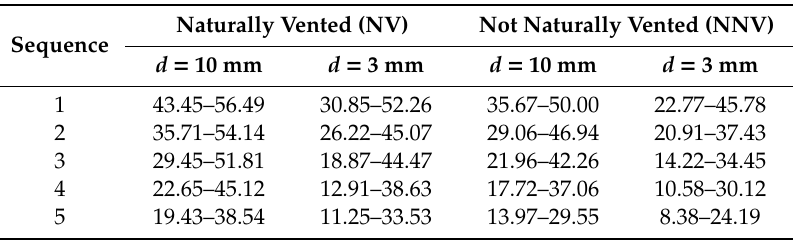
Table 8. Relative annual energy savings (%) for building A with PCM thickness of 3 mm or 10 mm.